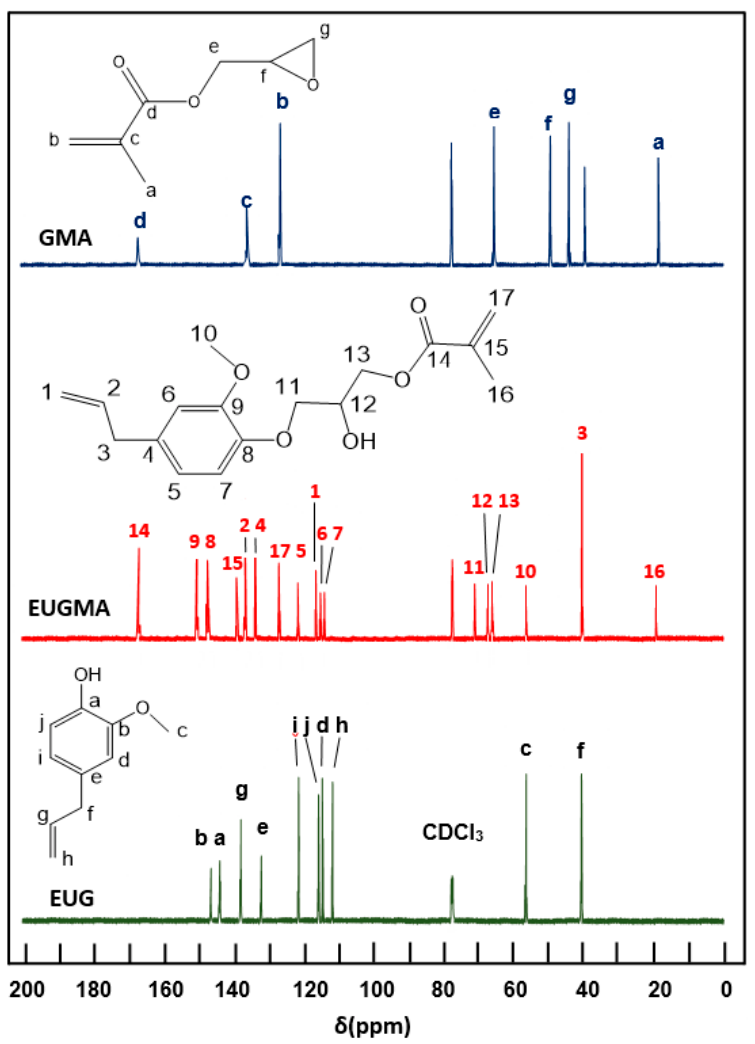
Figure 3. Carbon-13 nuclear magnetic resonance ( 13 C NMR) spectra of EUG, GMA, and EUGMA in CDCl 3 .